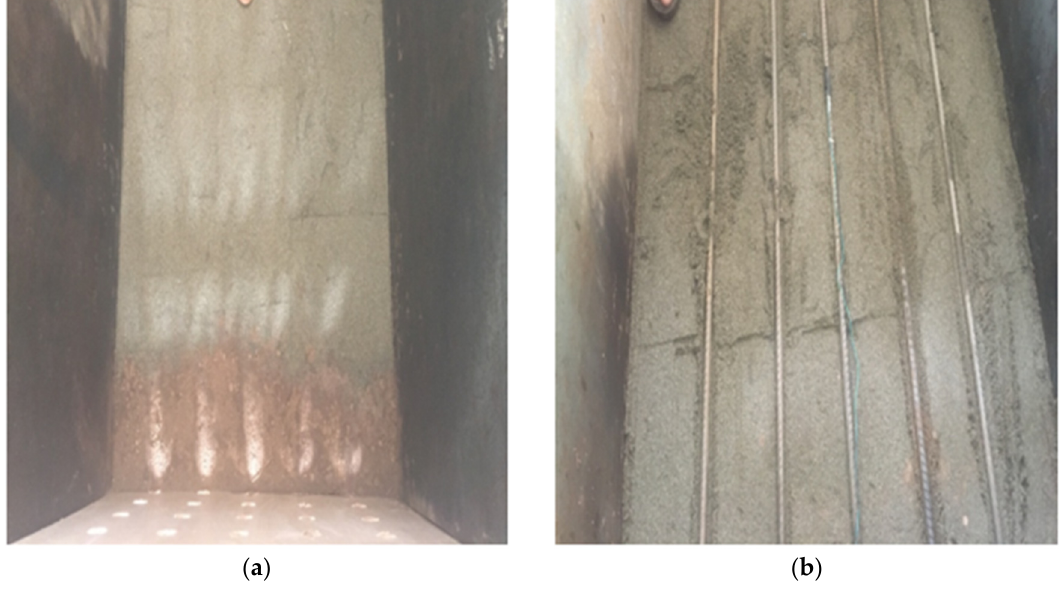
Figure 5. ( a ) The compacted sample of sand ( b ) MSE wall with strip arrangement.